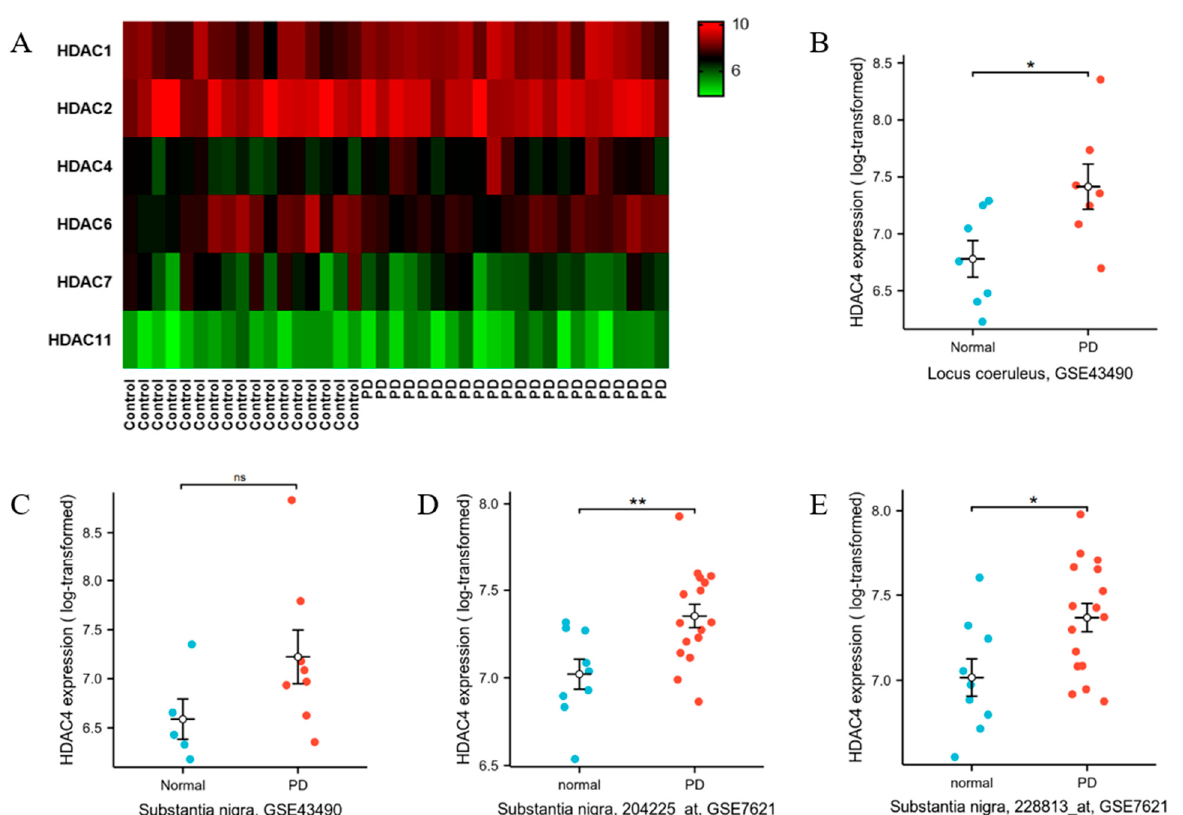
Figure 1. HDAC4 was highly expressed in PD brain tissues. ( A ) Gene expression profile of HDACs in PD dataset GSE43490. ( B , C ) Log-transformed RNA levels of HDAC4 from GSE43490 were analyzed. HDAC4 was significantly upregulated in the locus coeruleus of PD patients and tended to be increased in PD substantia nigra, with no statistically significant differences. ( D , E ) Log-transformed RNA levels of HDAC4 (two gene sites) from GSE7621 were analyzed. HDAC4 was significantly increased in the substantia nigra of PD patients. * p < 0.05; ** p < 0.01. ns., non-signi fi cant.